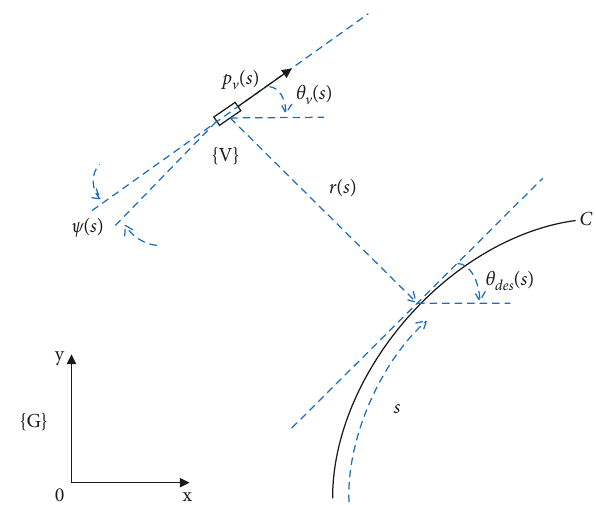
Figure 2: Vehicle modelling on the defined curvilinear